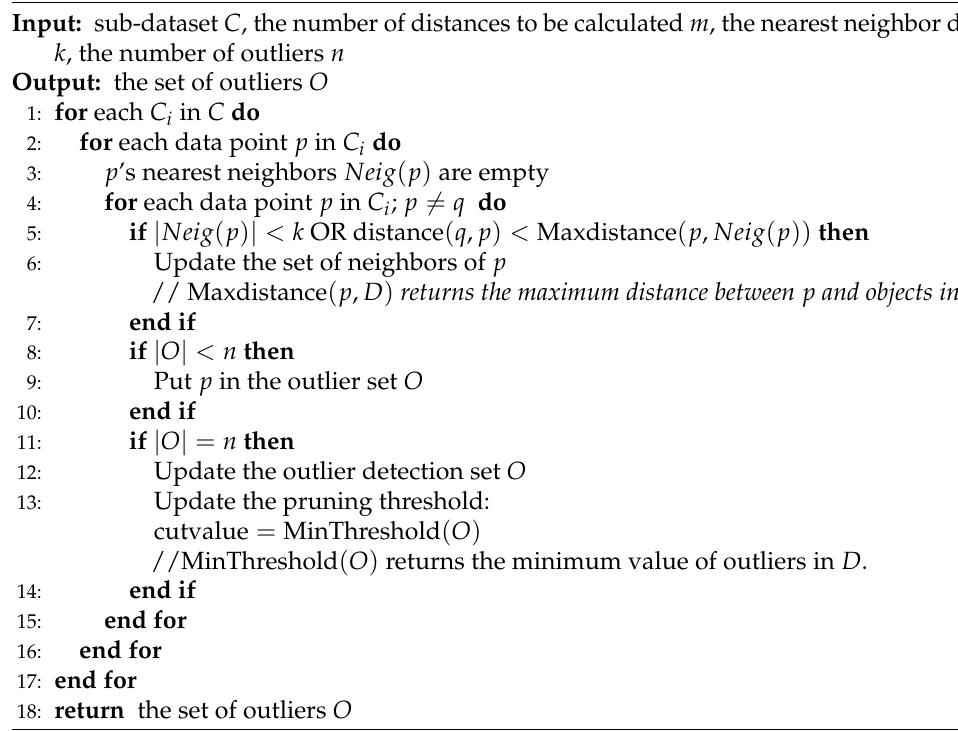
Algorithm 3 Outlier degree